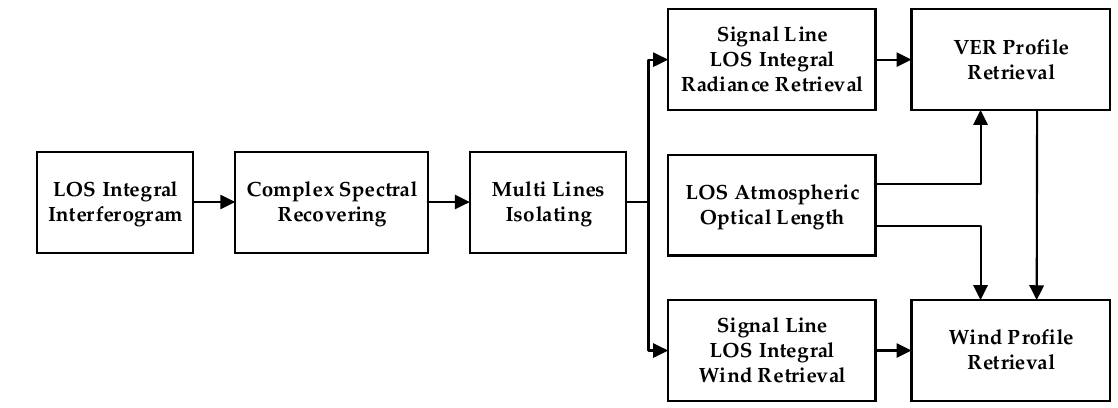
Figure 11. Multiple-emission-line retrieval strategy flow chart.